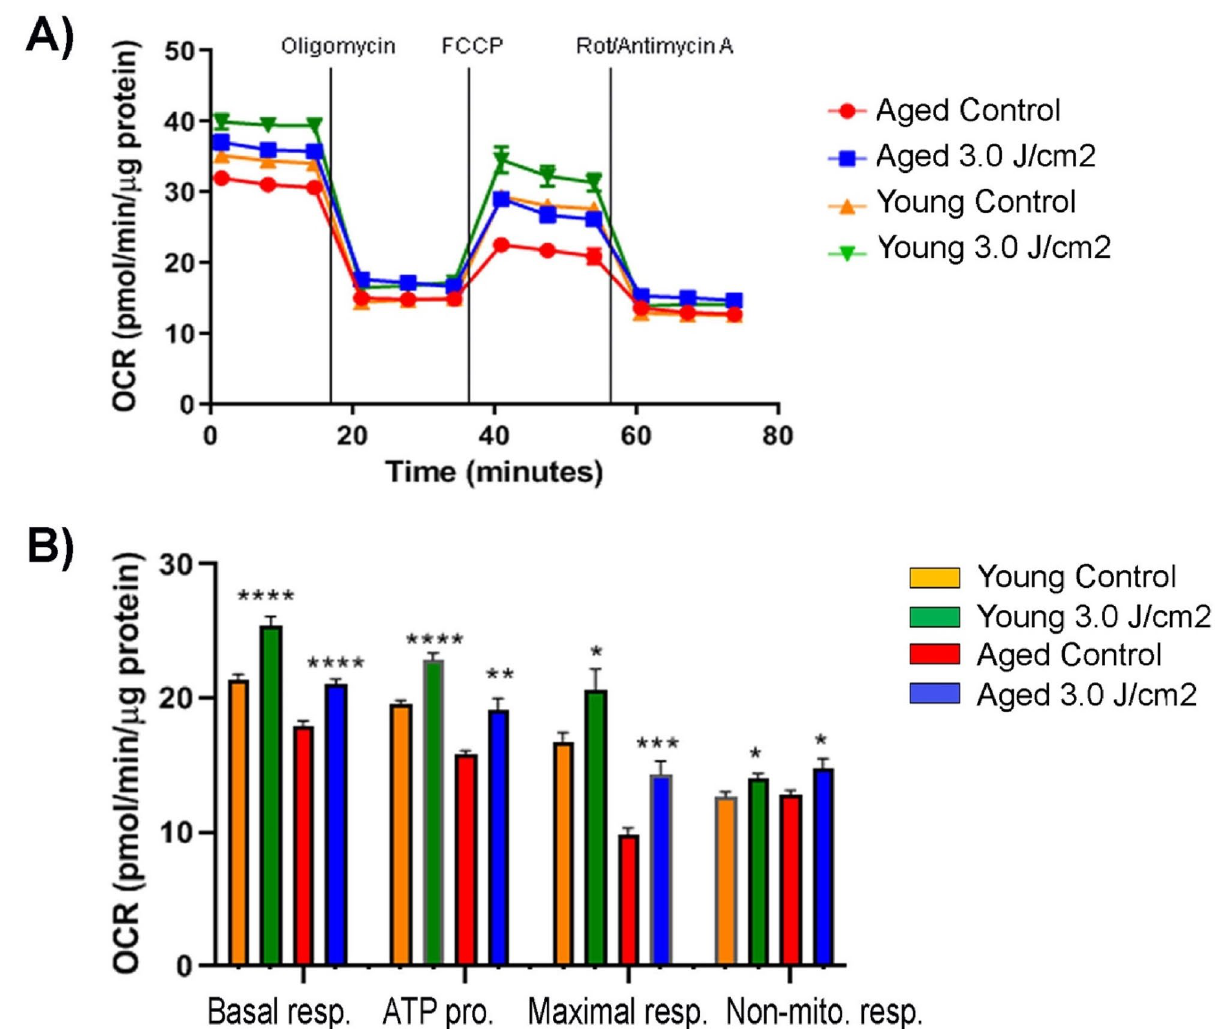
Figure 7. Effects of multiple doses of PBM on mitochondrial function of young and aged MSCs. Both young and aged MSCs underwent a PBM treatment at 3 J/cm 2 for three consecutive days, whereas the young and aged MSC control groups did not receive any treatment. Seven hours after the last treatment, OCR was measured under basal conditions and following sequential injections of oligomycin, FCCP, and rotenone/antimycin A compounds. Data were normalized to μg of protein. Shown are basal respiration, ATP production, maximal respiration, and non-mitochondrial respiration of young and aged MSCs as an OCR curve ( A ) and as a bar graph ( B ), with significant differences indicated by asterisk signs. The bars represent means ± standard error of mean. * p < 0.05; ** p < 0.01; *** p < 0.001; **** p <